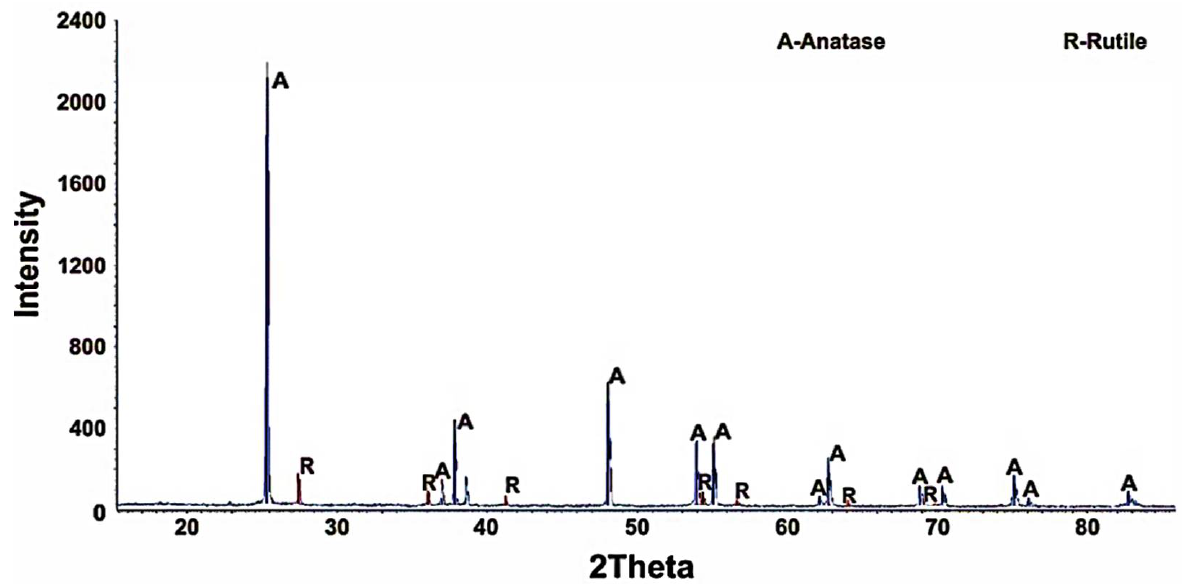
Figure 8. Effect of the duration of the leaching process of manganese, iron, and chromium on hydrochloric acid solution.